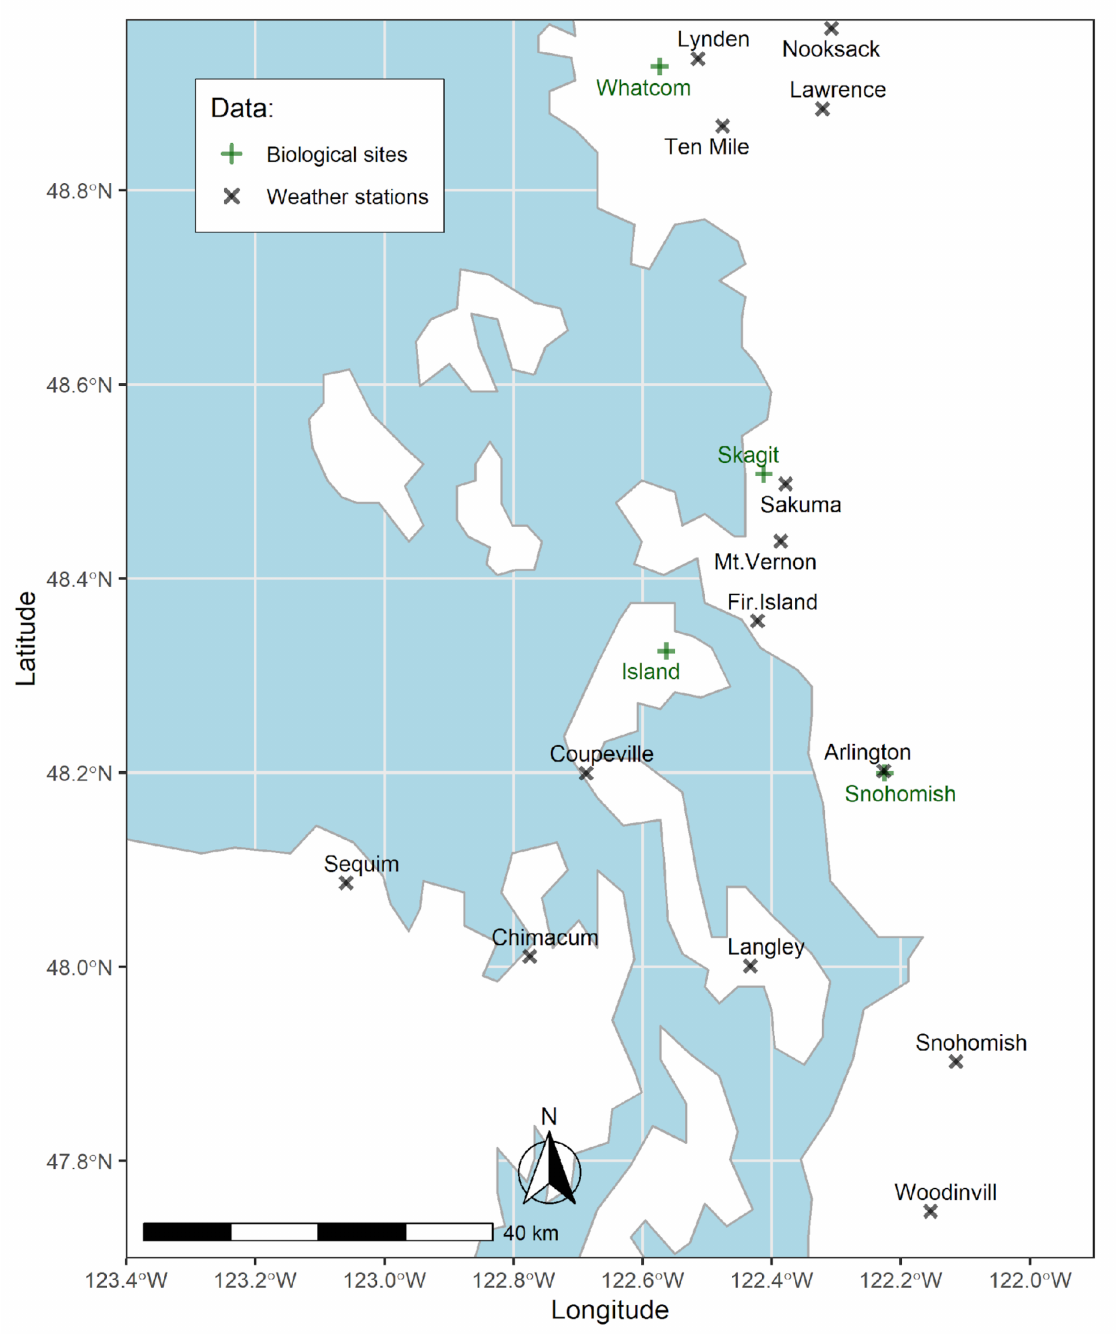
Figure 1. The geographical domain of the study area in northwestern Washington, USA. Green plus signs and black cross signs represent sites with biological data and locations of weather stations,